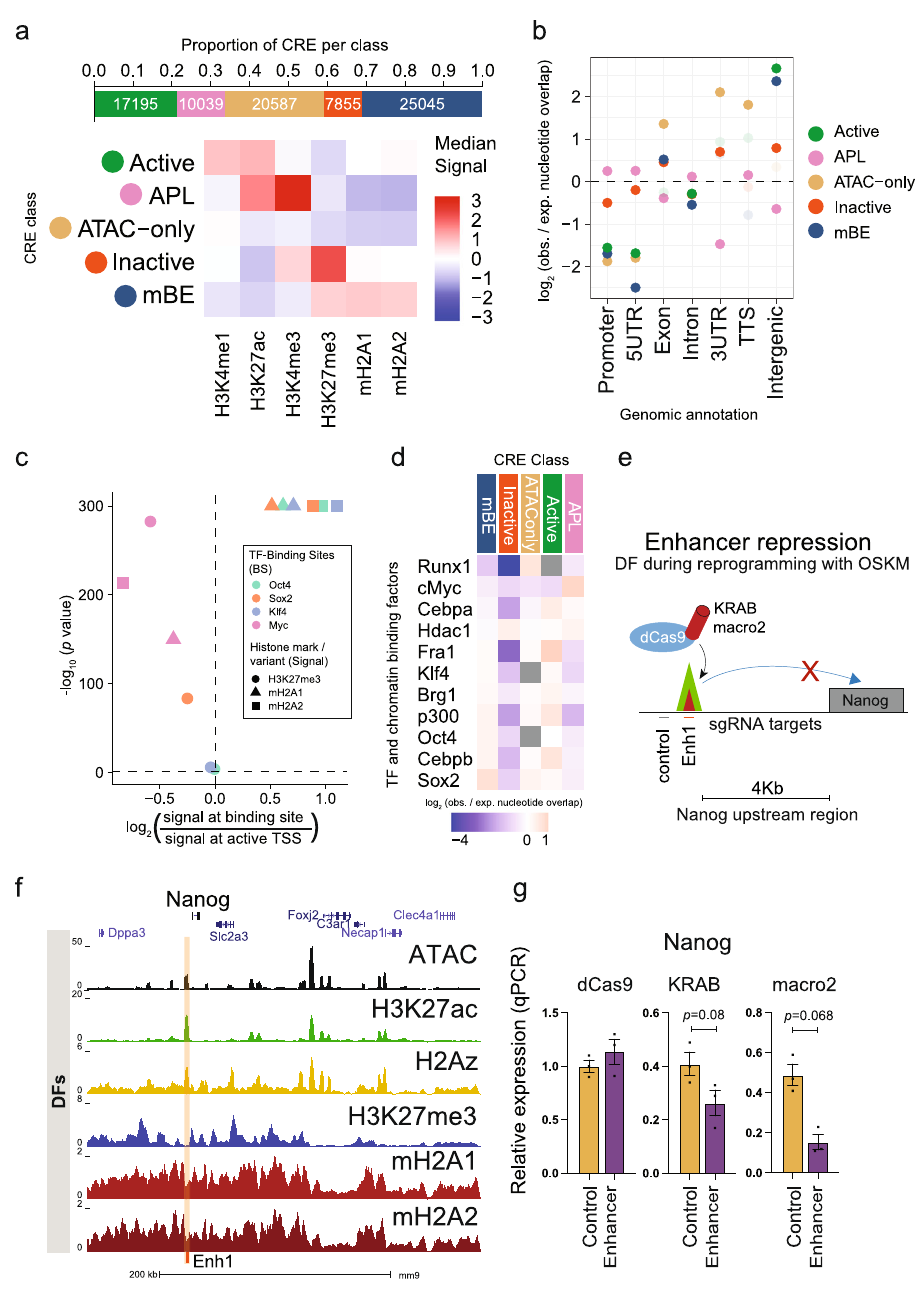
Fig. 3 MacroH2A is a negative modulator of enhancer activity. a Proportion of CRE peaks in each CRE class (top) and heatmap (bottom) showing median Z scores of the log-normalized input-corrected ChIP-seq signal of the 6 histone marks/variants used in classifying the CRE peaks in each class in dermal fi broblasts (DF). b Genomic region enrichment of the CRE peaks in each class as calculated by GAT (enrichments that are statistically signi fi cant, Benjamini-Hochberg corrected p -value < 0.05, are shown in darker colors, and the rest in lighter colors). c Volcano plot showing the enrichment of the signals of macroH2A variants and H3K27me3 at the binding sites (BS) of Oct4, Sox2, Klf4 and cMyc (48 h after OSKM induction, binding sites data collected from Chronis et al. 37 ), relative to the signals at active TSS (AT) regions in dermal fi broblasts (Mann – Whitney U test). Active TSS (AT) regions are de fi ned as 500 bp up- and downstream of the transcription start sites that have RPKM> 1 measured by RNA-seq experiments on dermal fi broblasts. d Enrichment of TF and chromatin binding factors after 48 h of OSKM expression 37 , at CRE sites of DF cells as calculated by GAT, ranked by enrichment in mBE (enrichments that are not statistically signi fi cant, Benjamini-Hochberg corrected p -value > 0.05, are shown in gray). e Schematic of enhancer targeting in DF during reprogramming with OSKM using dCas9-KRAB and dCas9-macro2 and sgRNAs complementary to regions around the enhancer site. f UCSC genome browser snapshot of the Klf4 binding site upstream of the Nanog TSS in DF with open chromatin (ATAC-seq), H3K27me3, H3K27ac, H2A.Z, mH2A1 and mH2A2 data. g Nanog relative expression after 96 h of OSKM infection in DFs with dCas9, dCas9-KRAB or dCas9-macro2 (unpaired two tailed student ’ s t -test, p = 0.068) with sgRNAs targeting the enhancer site upstream of Nanog or control. Data are mean with SE ( n =